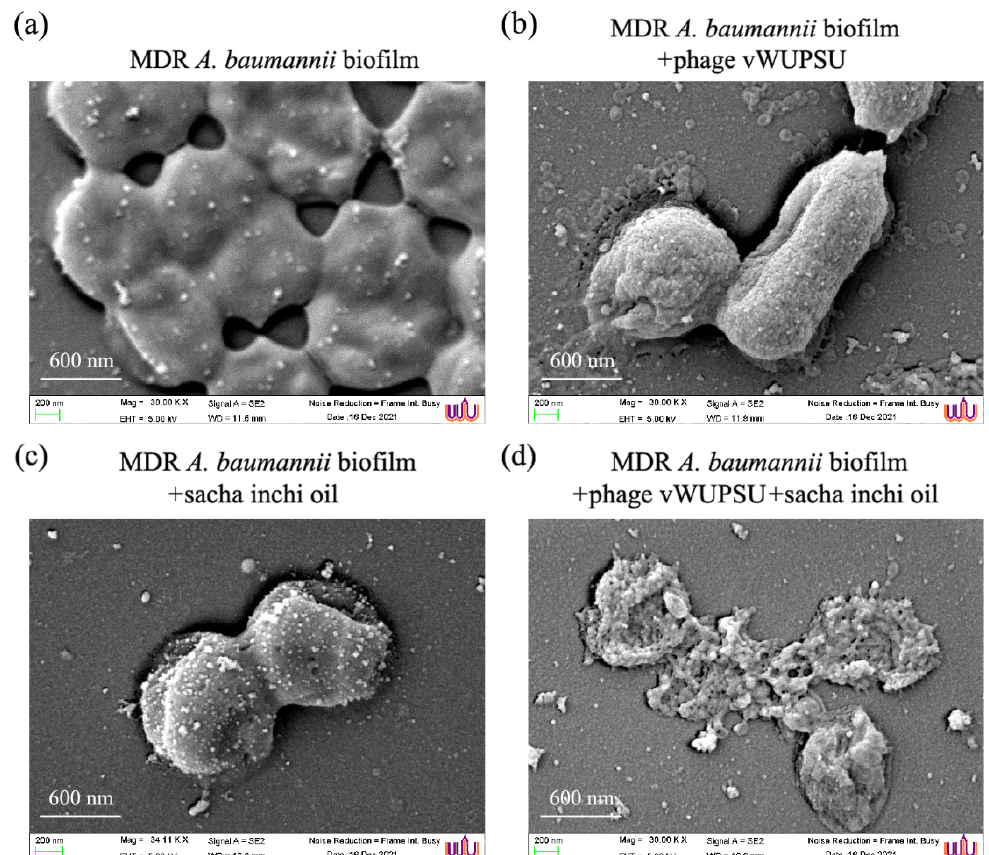
Figure 11. Ultrastructural analysis of MDR A. baumannii biofilm after treatment with the combination of phage vWUPSU and sacha inchi oil. The biofilms of MDR A. baumannii cells were formed and then treated with ( a ) only TSB, ( b ) phage vWUPSU at an MOI of 1, ( c ) sacha inchi oil at 0.5 × MIC, and ( d ) the combined phage vWUPSU and sacha inchi oil. The cells were observed under a field emission scanning electron microscope at an acceleration voltage of 5 kV (30,000 × magnification). The scale bar represents 600 nm.